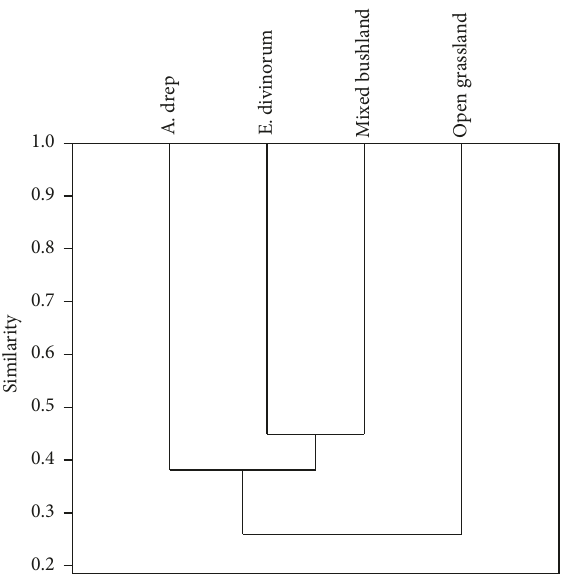
Figure 3: Percentage similarity in wildlife species composition of 4 habitats in OPC.